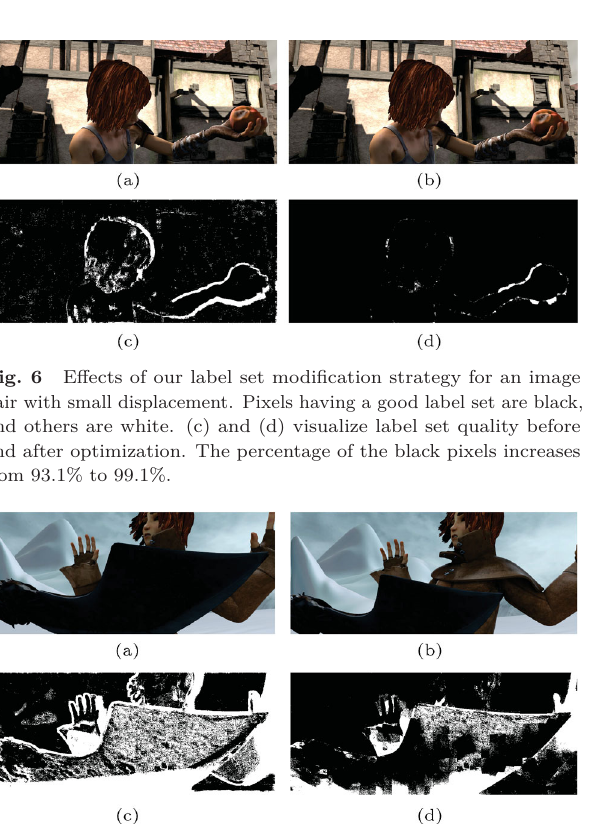
Fig. 7 Effects of our label set modification strategy for an image pair with large displacements. Pixels having a good label set are black, and others are white. (c) and (d) visualize label set quality before and after optimization. The percentage of the black pixels increases from 53 . 6% to 78 .